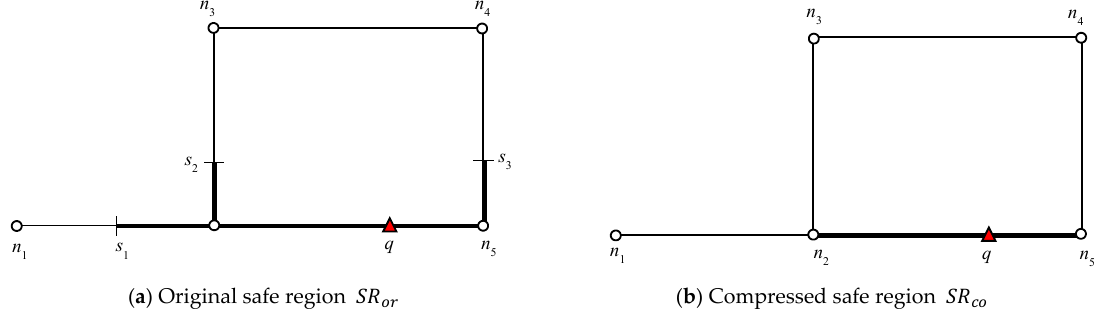
Figure 11. Difference between original safe region SR or and compressed safe region SR co . ( a ) Original safe region SR or ; ( b ) Compressed safe region SR co .